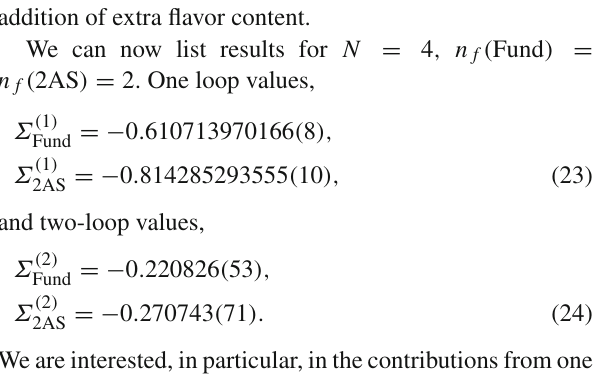
Fig. 2 The solution of Eq. (27) for N = 2 , 3 , 4 and β = 11 , the value used in the numerical simulations, as will be described in Sect.